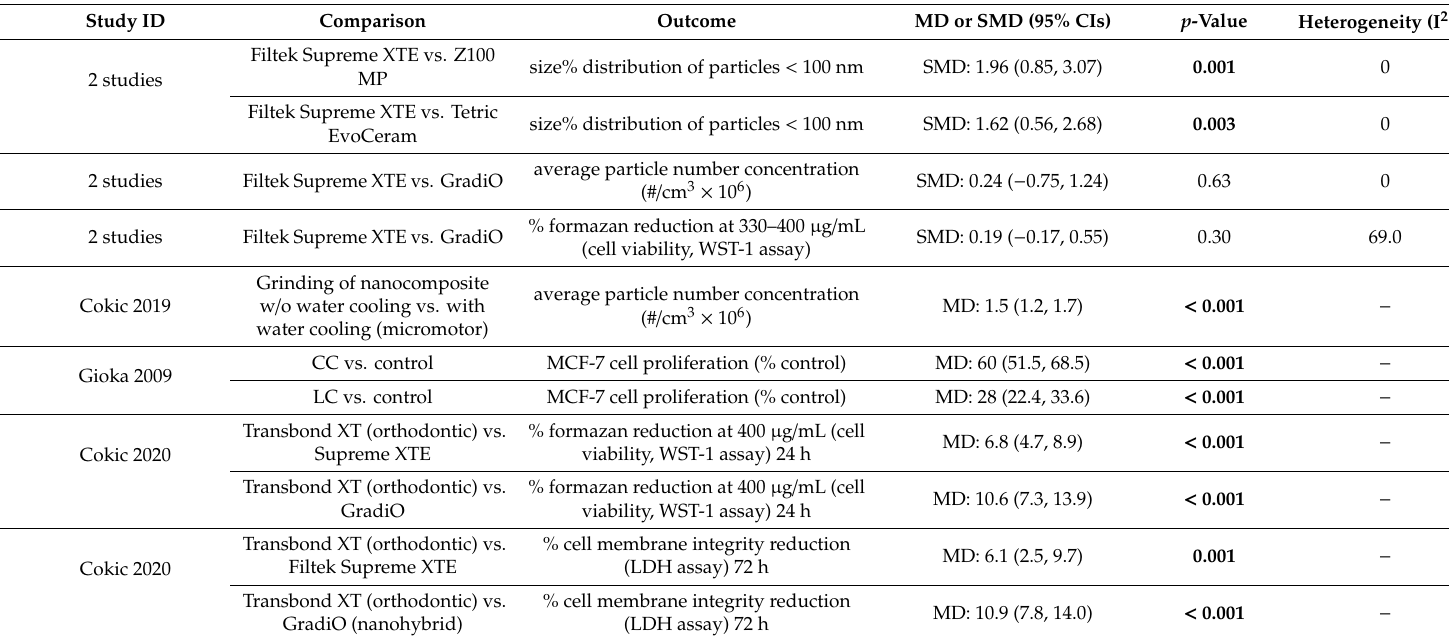
Table 4. Quantitative data from meta-analyses and individual single studies for related comparisons and outcomes. The minus sign ( − ) shows larger e ff ect for the second group under comparison. Bold indicate statistically significant